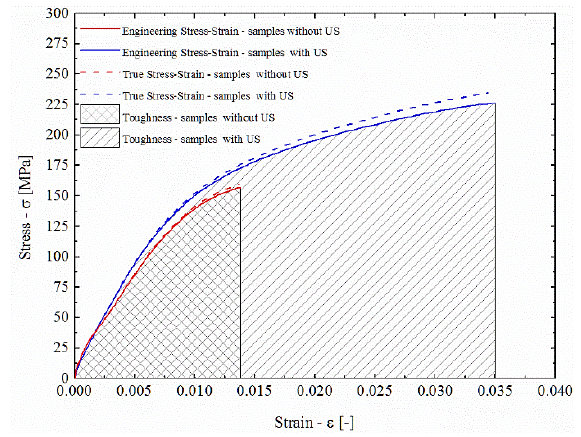
Figure 5. Mean static mechanical properties of as-cast AZ91 D alloy for both non-treated and US treated